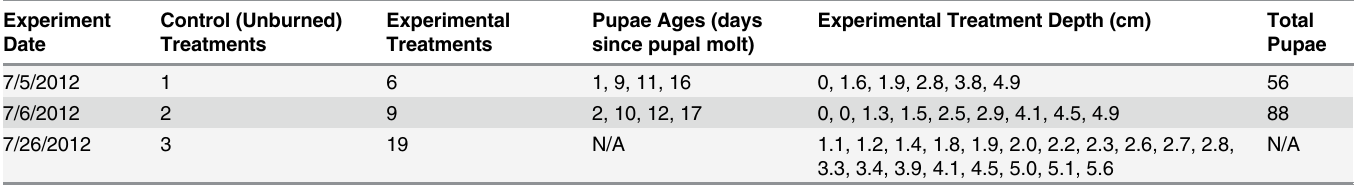
Table 3. Experimental treatment numbers for prescribed fire survival experiments conducted at the Ordway-Swisher Biological Station, Putnam County, Florida, in July,